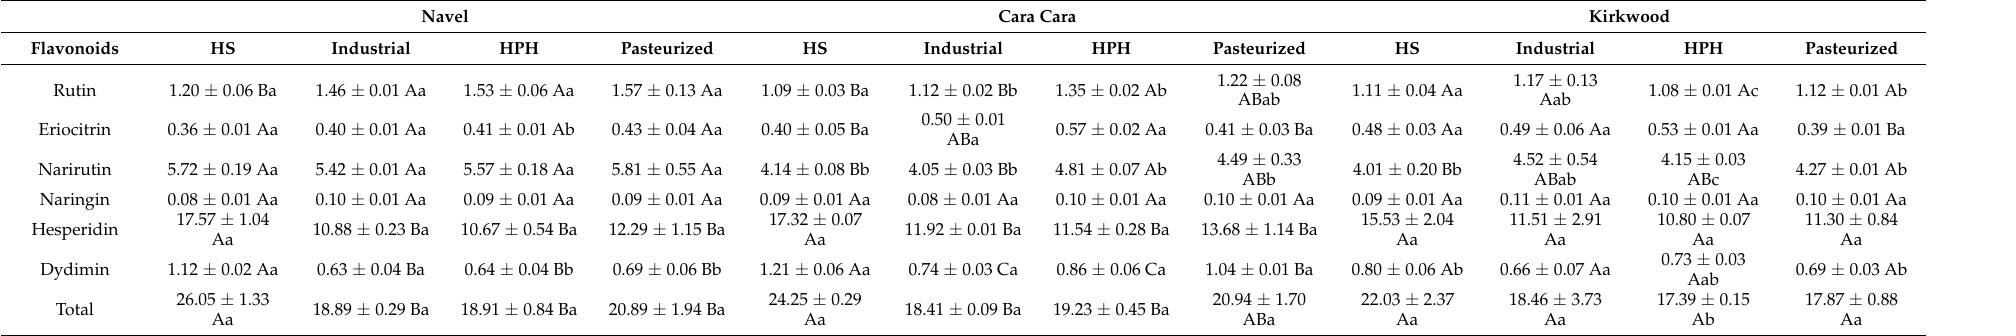
Table 4. Flavonoid content and composition (mg/100 mL) of HS (hand-squeezed), industrial, HPH (high-pressure homogenized), and pasteurized juices of Navel, Cara Cara, and Kirkwood